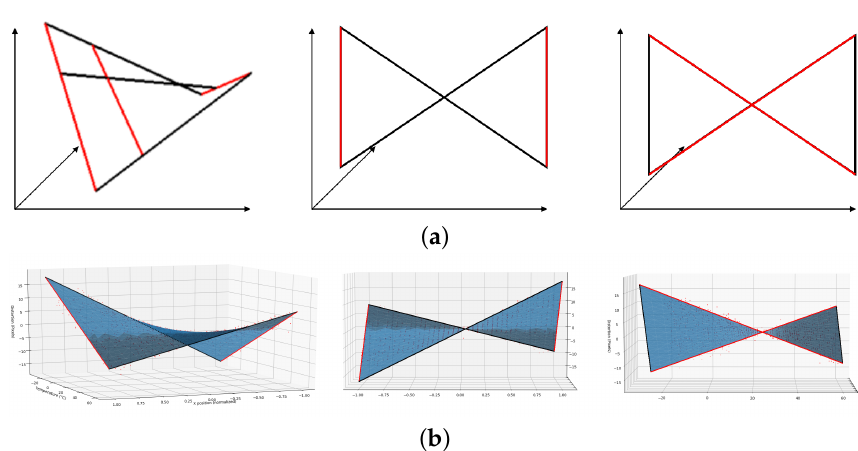
Figure 6. Different views of ( a ) an hyperbolic paraboloid function defined as the union of the lines joining two points moving on two non-coplanar lines and ( b ) the D E function that models the distortion error of the IR images due to temperature